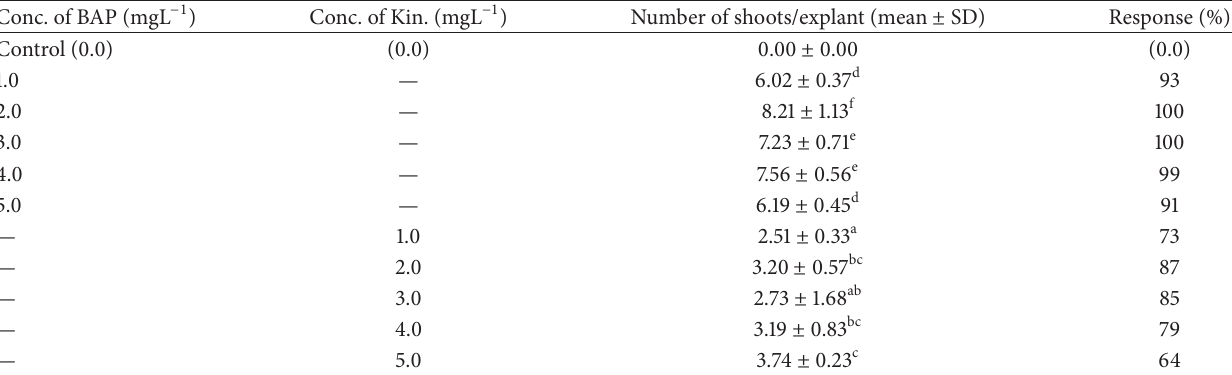
Table 1: Effect of cytokinins (BAP and Kin) on induction of shoots from explants of P. edulis after 4 weeks. Conc. of BAP (mgL −1 ) Conc. of Kin. (mgL −1 ) Control